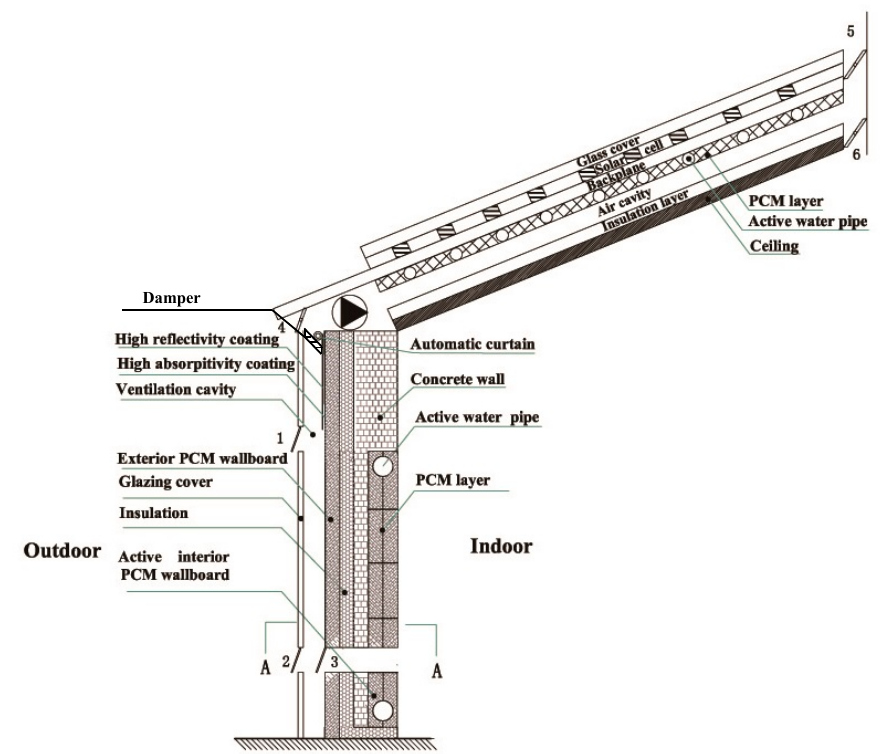
Figure 1. Detailed construction of the proposed hybrid system.